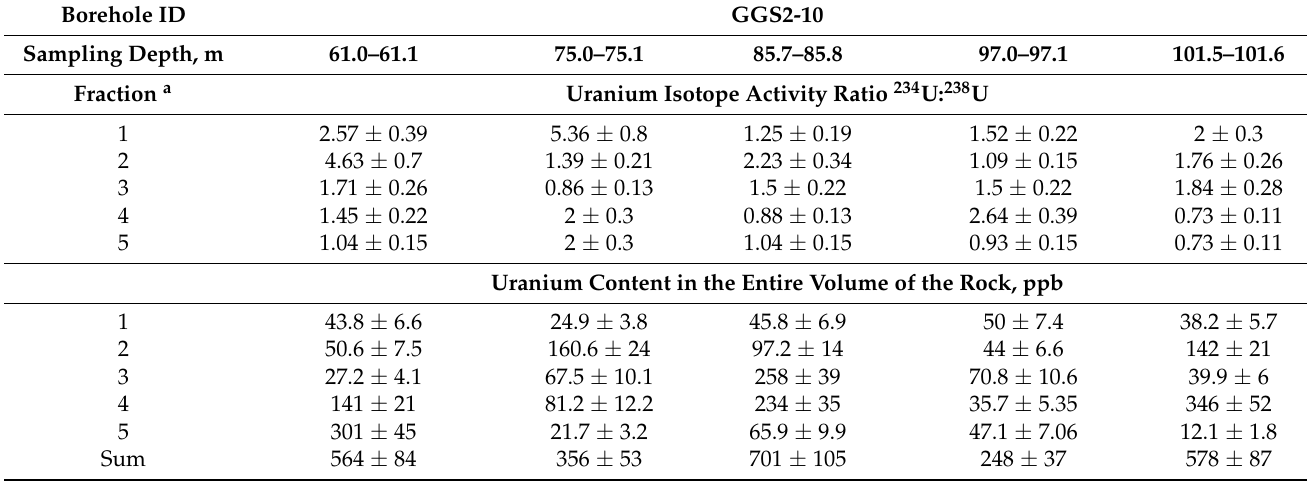
Table 1. Distribution of uranium and measured 234 U: 238 U activity ratios in sequential extracted